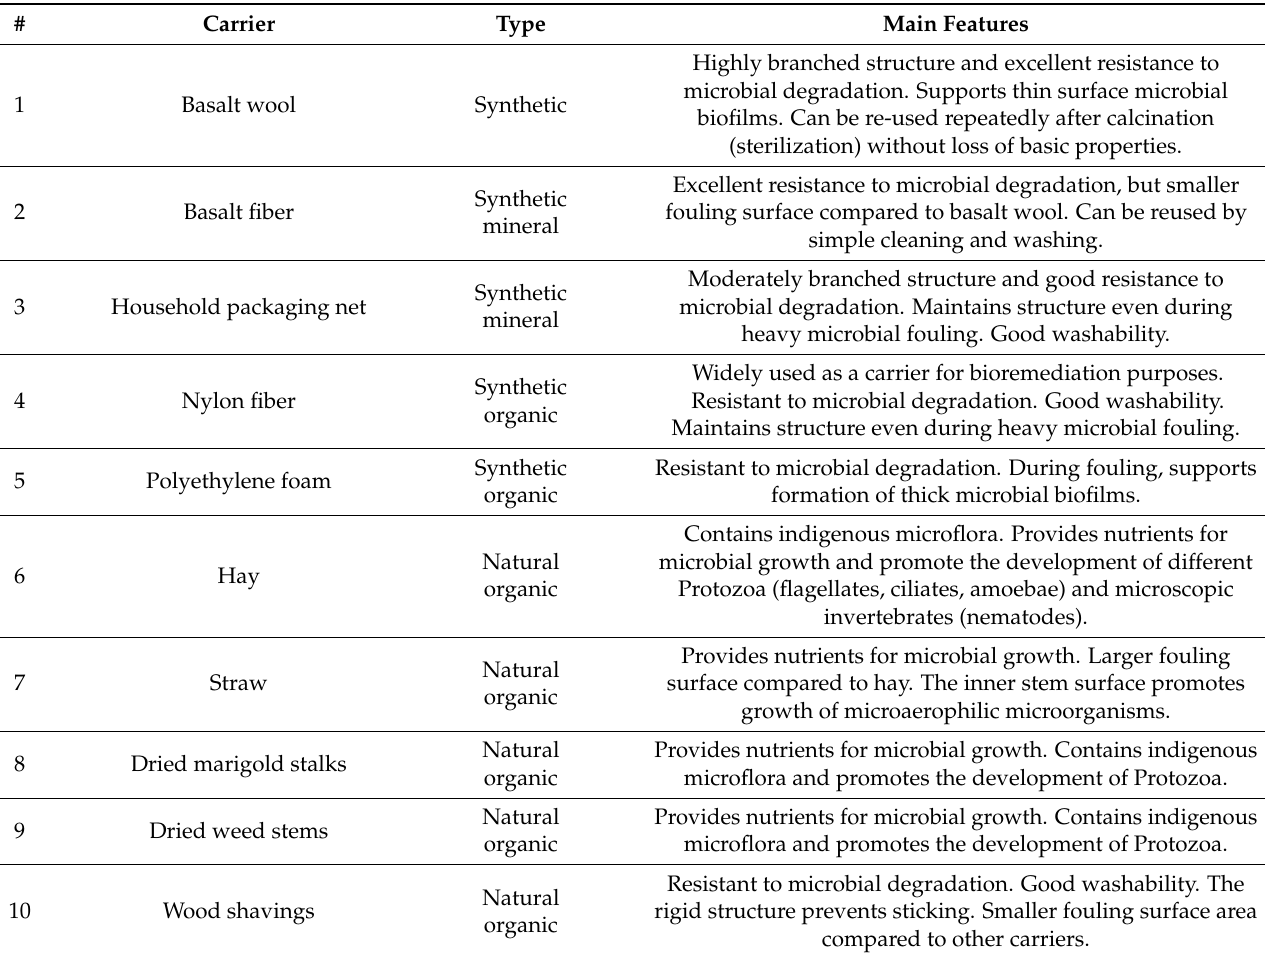
Table 1. Carrier materials used to immobilize